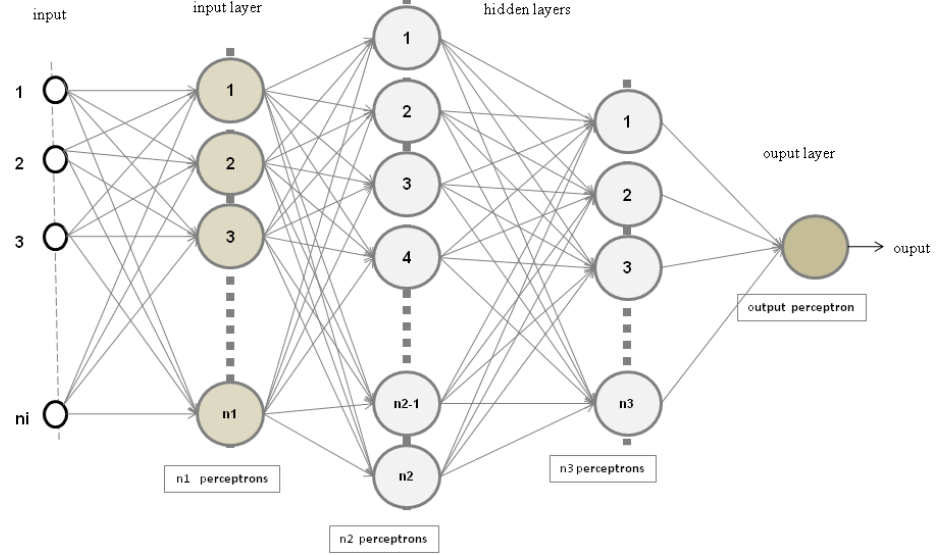
Figure 2. Schematic diagram of a multilayer neural network (two hidden